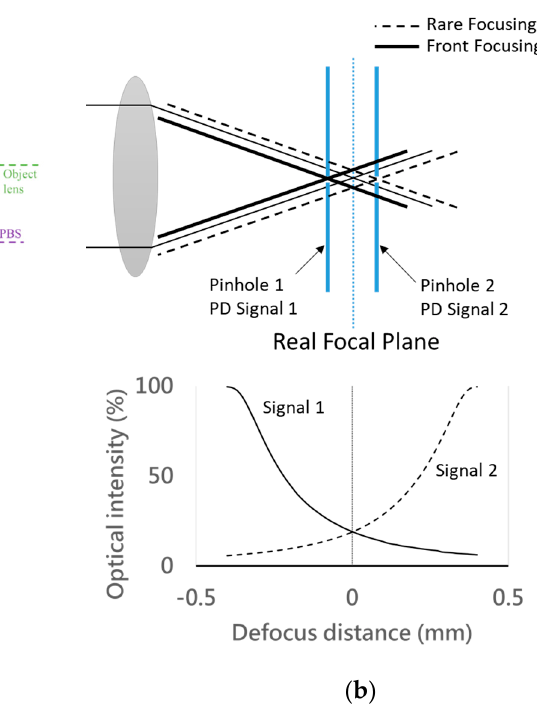
Figure 2. Proposed dual-confocal autofocusing system: ( a ) schematic illustration and ( b ) simulation of the front and the rear focal positions (intensity distribution). Table 1. Comparison of prior autofocusing system